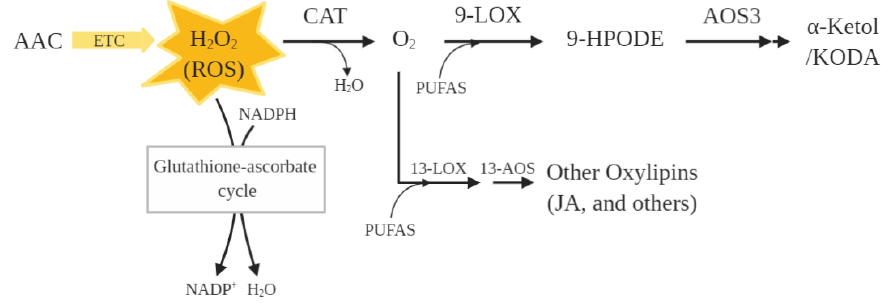
Figure 4. Simplified scheme of differentially abundant proteins between potato tubers from cultivars at the endodormancy stage involved in oxylipin biosynthesis.